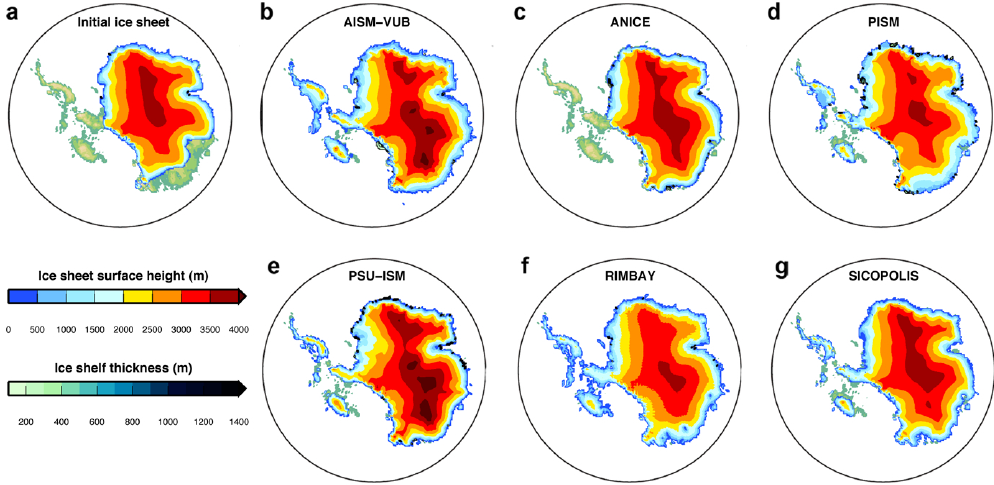
Figure 6. Ice surface topography and thickness of the ice shelves for the Pliocene Ice-PRISM3 simulation, with HadCM3 Pliocene climate forcing. (a) Initial PRISM3 ice sheet with Bedmap1, (b) AISM, (c) ANICE, (d) PISM, (e) PSU-ISM, (f) RIMBAY, (g)